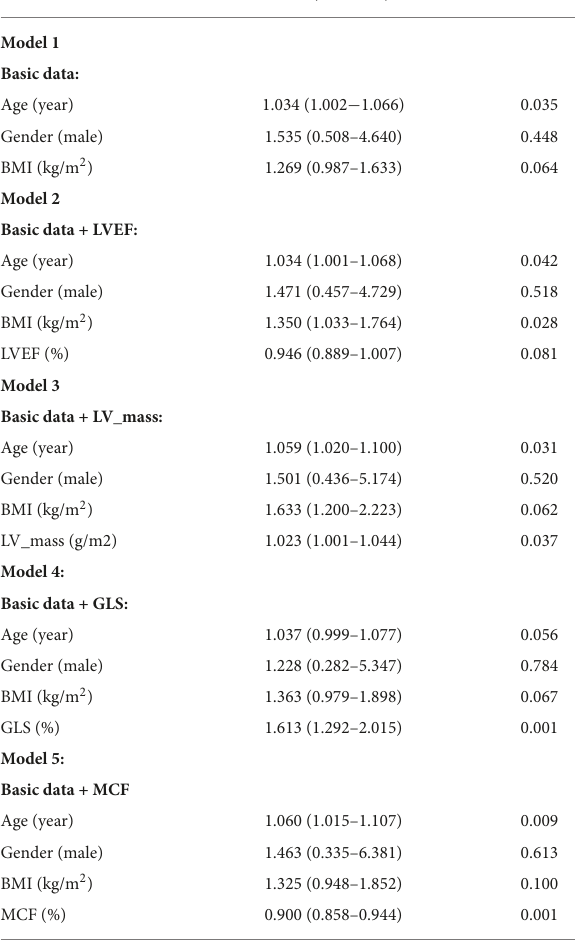
TABLE 4 Multivariate analysis (logistic regression) models showing odds ratio to predict the presence of LGE. OR (95% CI) P -value